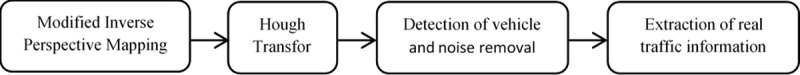
Global description of extract real traffic information.